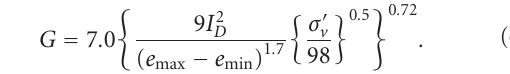
Figure 3: Normalized total end-bearing capacities of K-7 and TO sands.